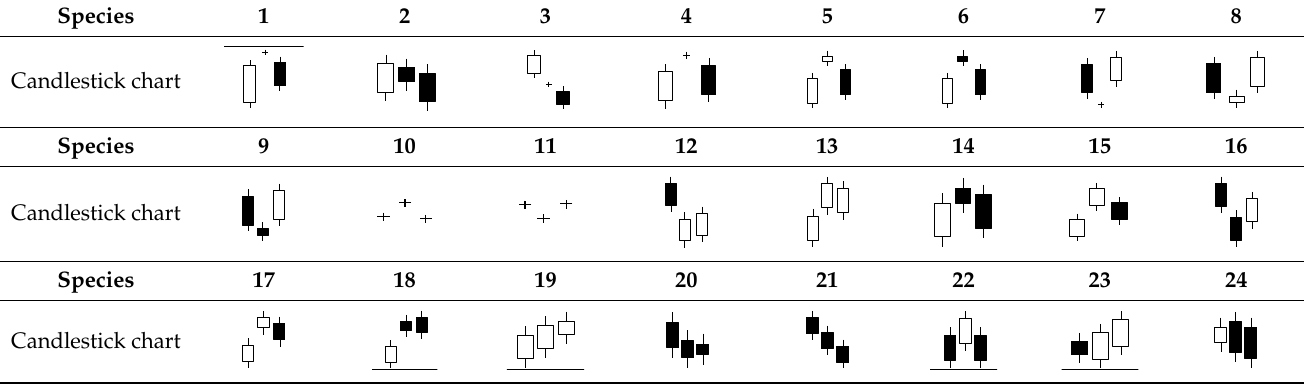
Table 1. Twenty-four categories of the three-day candlestick chart combinations for the water quality data at the prediction station.